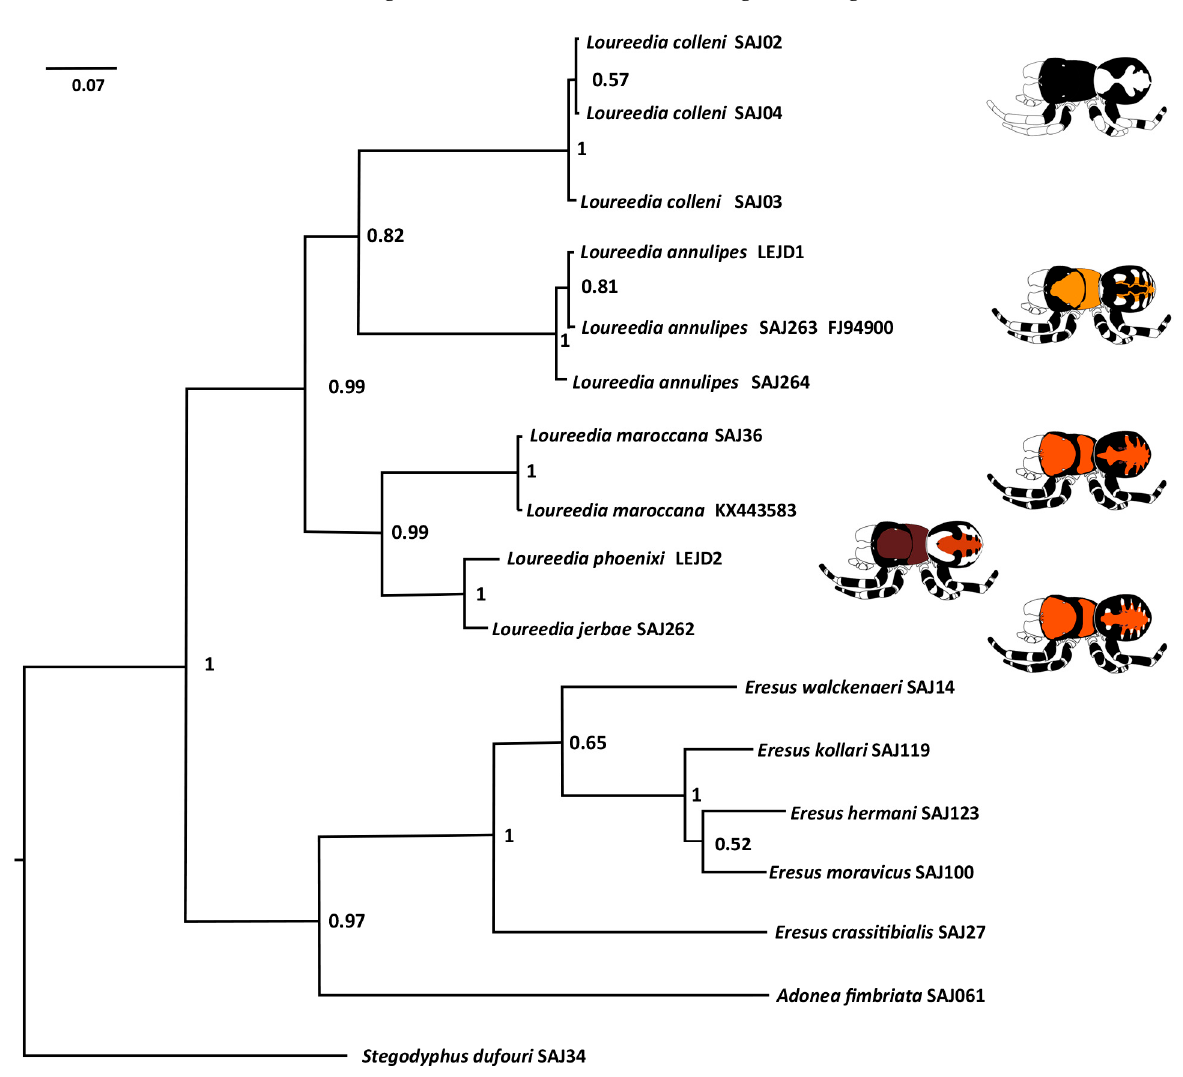
Figure 17. Bayesian phylogenetic tree based on COI sequences . Support values are posterior proba-